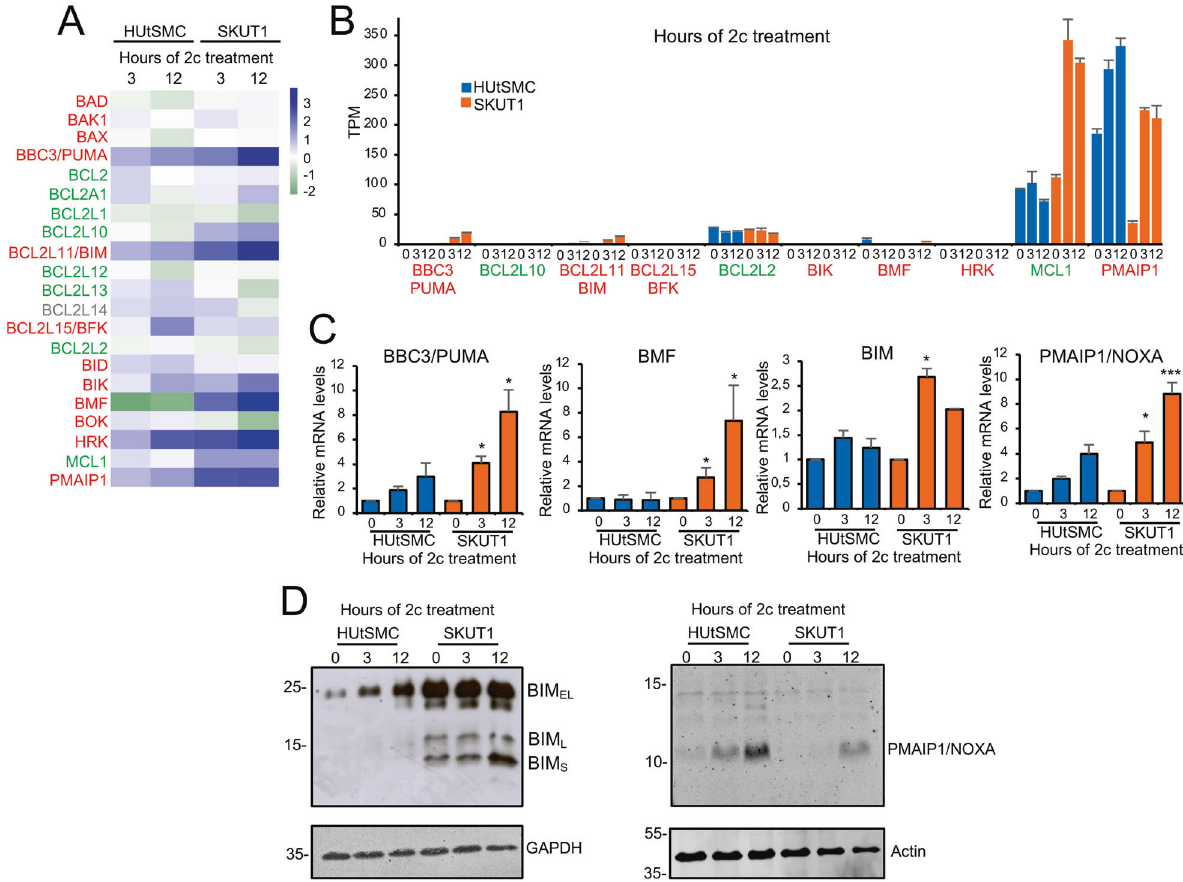
Fig. 2 The expression of BCL2-family members in response to 2c-induced proteotoxic stress. A Heat-map reporting the expression levels (log2-fold change relative to untreated cells) of the BCL2 family members in response to 2c-induced proteotoxic stress in non-transformed and LMS cells. Anti-apoptotic members are indicated in green and pro-apoptotic in red. In gray BCL2L14 which activity is still debated. B Expression of the indicated BCL2-family members in HUtSMC and SK-UT-1 cells treated or not with 2c for the indicated times. Expression values are shown in transcripts per million (TPM) calculated from a gene model where isoforms were collapsed to a single gene. C qRT-PCR analysis of the mRNA levels of the indicated BH3-only members genes in HUtSMC or SK-UT-1 cells treated with 5 µmol/L of 2c for the indicated times. D Cells were treated for the indicated times with 2c (5 µmol/L). Immunoblots were performed using the indicated antibodies. Actin or GAPDH were used as the loading